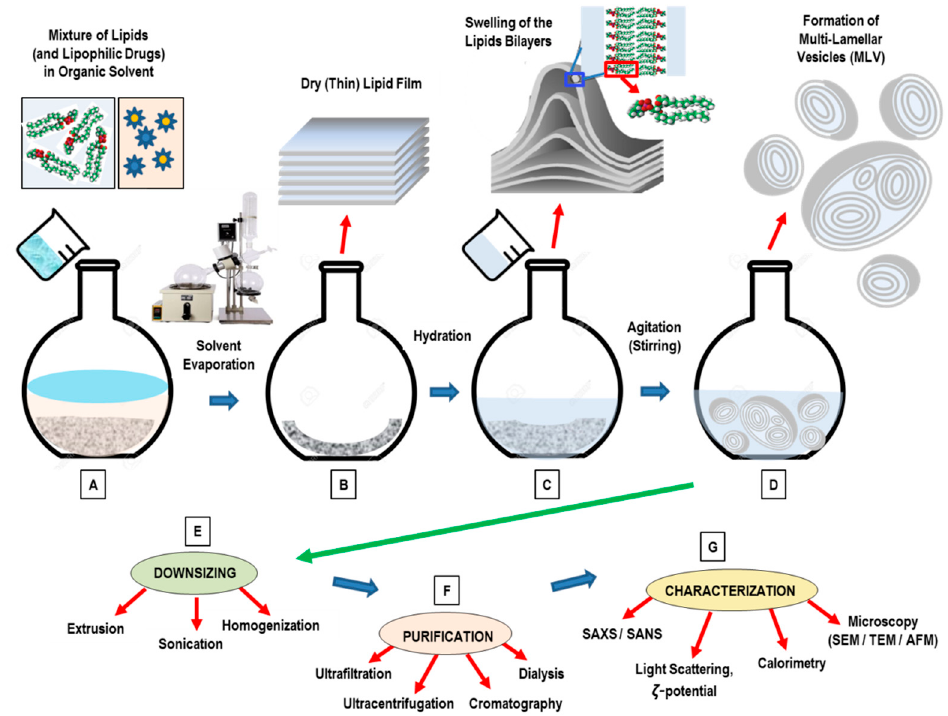
Figure 3. Schematic representation of the main stages of the thin-film hydration method of liposome preparation. The main lipid components (and eventually lipophilic drugs/macromolecules) are dis- solved in organic solvent ( A ). After the evaporation of the solvent, a dry (thin) lipid film is formed ( B ). The lipid film is then rehydrated in a saline buffer (eventually containing hydrophilic dugs to be entrapped), causing a swelling of the lipid bilayers’ stacks ( C ). The successive agitation/stirring of the sample favors the formation of (polydispersed) multilamellar vesicles ( D ). The final stages of the production process include the liposomes’ downsizing ( E ), purification ( F ), and characterization ( G ).